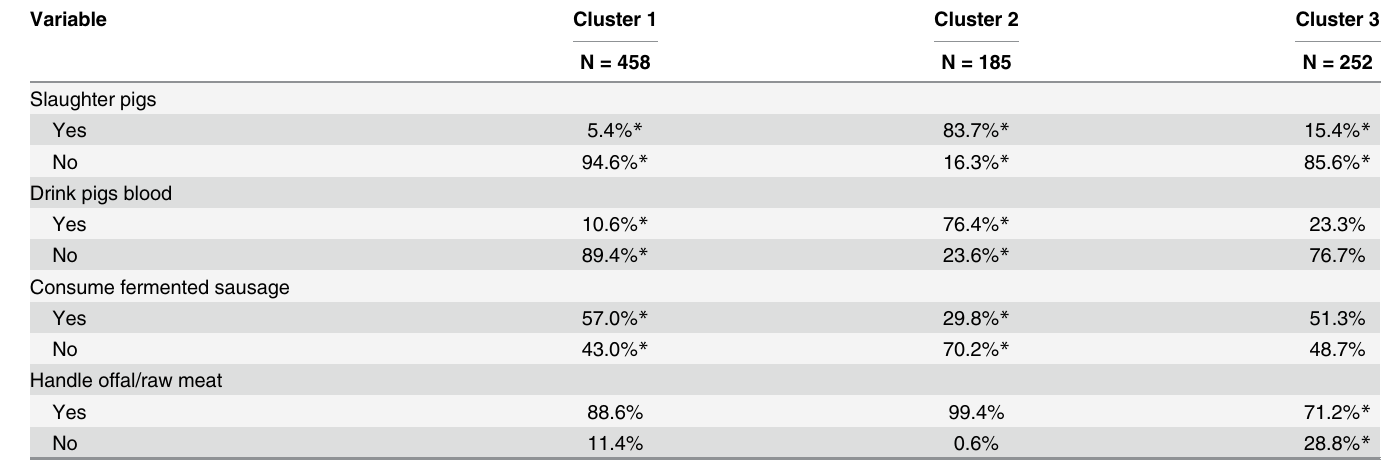
Farmers that called an animal health worker (or similar) if their pig was sick had 0.38 (95% CI: 0.18 to 0.80) times the odds of having pigs test seropositive for T . spiralis , compared to farmers which reported self-treating their pigs (Table 4). Pigs kept in tethered systems had 0.85 (95% CI: 0.18 to 0.91) times the odds of testing seropositive for hepatitis E compared to those in penned systems. Further; households that disposed of pig manure in water sources had 2.39 (95% CI: 1.07 to 5.34) times the odds of testing seropositive for hepatitis